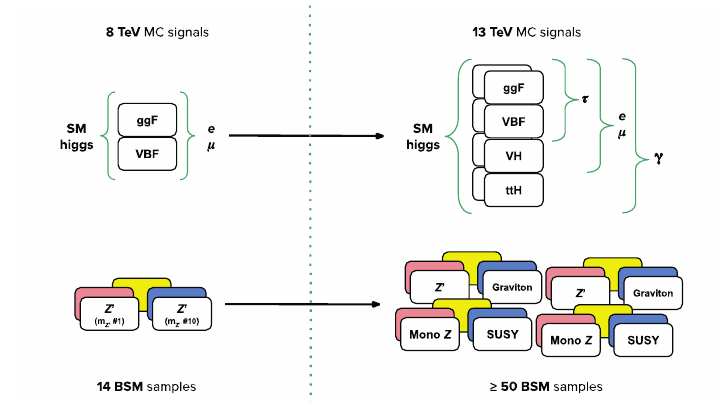
Figure 2. Evolution of ATLAS Open Data SM Higgs and BSM MC signals from the 8 TeV release (2016) to the 13 TeV release (2019/2020).